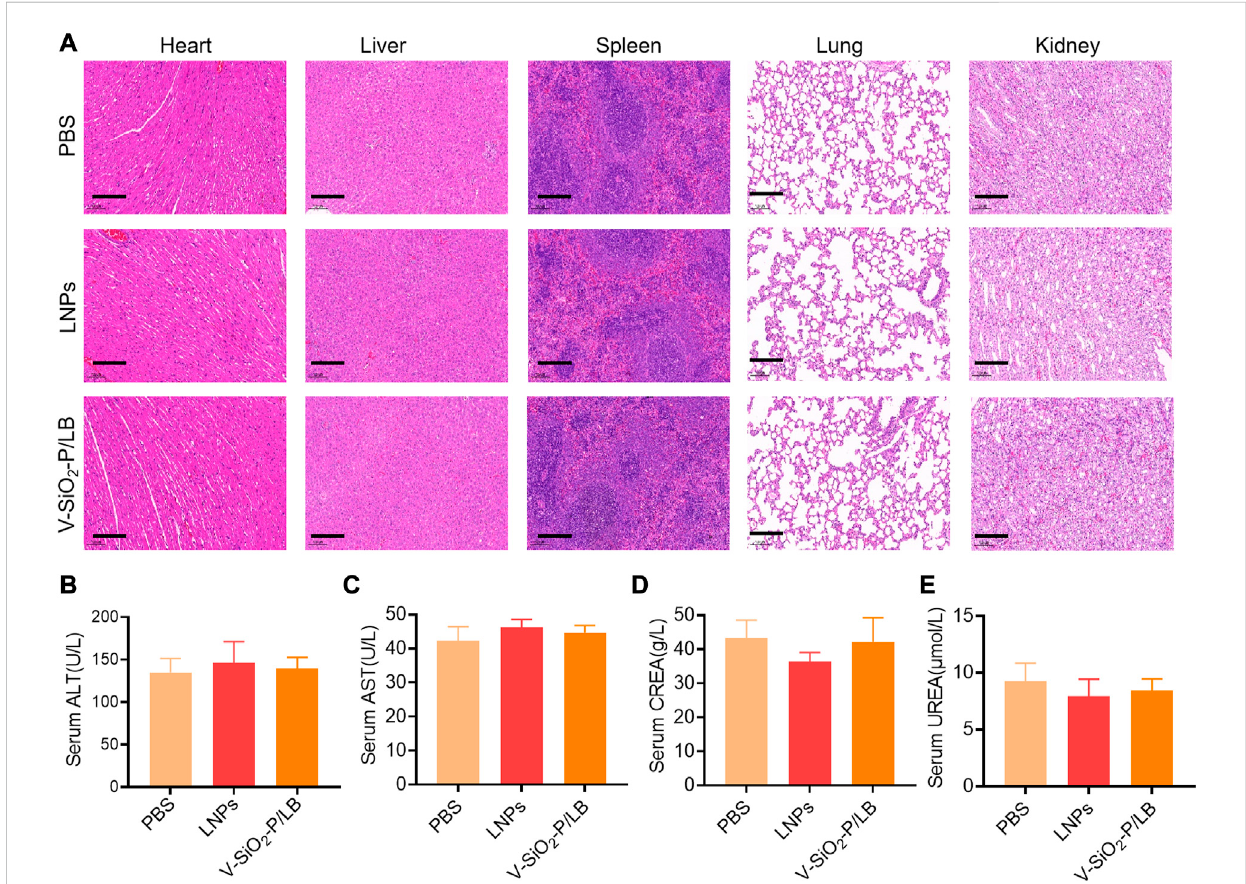
FIGURE 5 BiosafetyofV-SiO 2 -P/LBnanoparticles invivo .(A) HistopathologicalexaminationofvitalorgantissuesafterintravenousinjectionofPBS,LNPs,and V-SiO 2 -P/LB nanoparticles (3 mg/kg, 200 μ L) and saline (200 μ L) once daily for 7 days by H&E staining. Scale bars, 200 μ m. n = 3 mice per group. Detection of serum (B) ALT, (C) AST, (D) CREA and (E) UREA levels after the acute toxicity test. n = 3 mice per